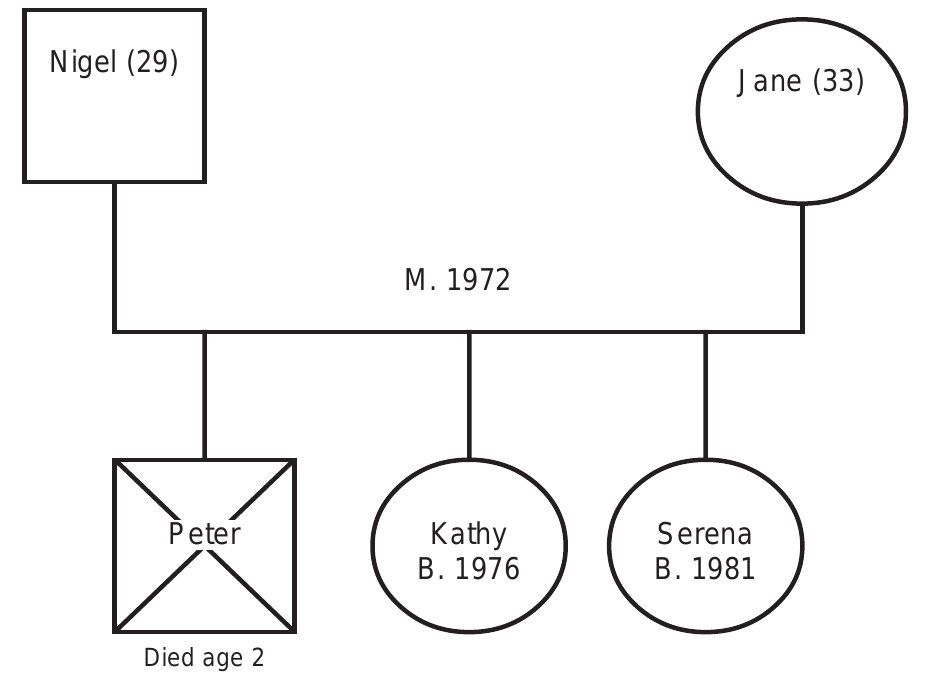
Figure 1. A visual representation of the family story of Nigel and Jane